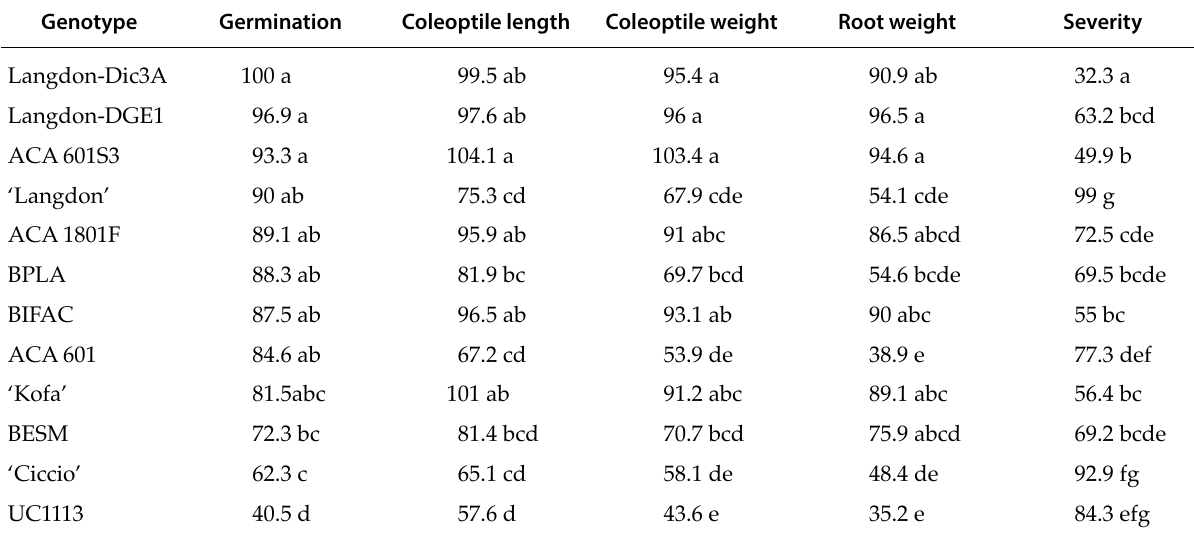
Table 5. Means of seedling variables (% of control) and disease severity (% symptomatic spikelets/spike) for 12 wheat genotypes after inoculation with Fusarium graminearum .